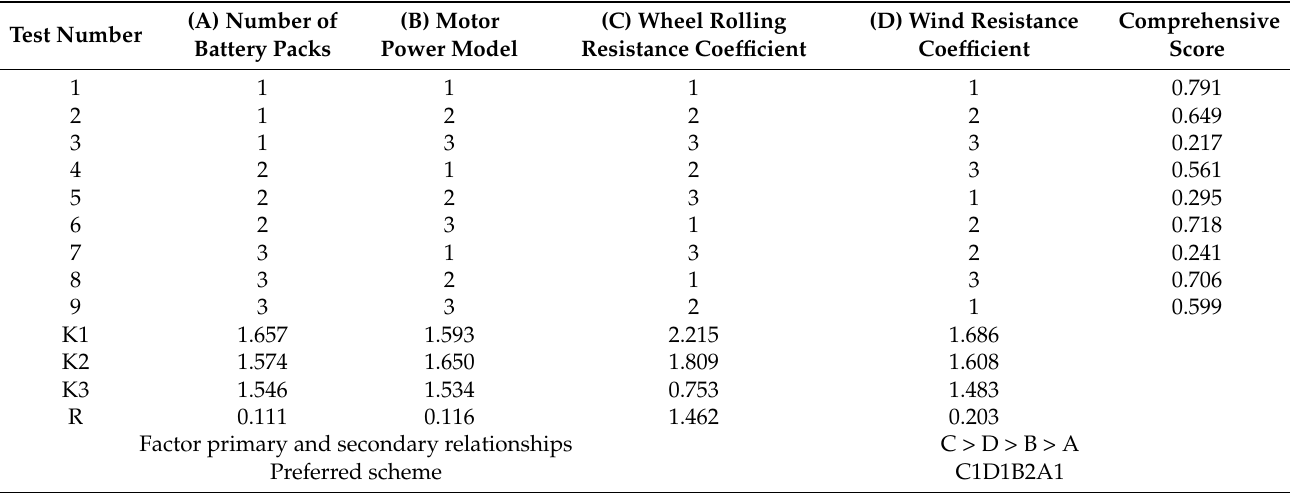
Table 14. Analysis table of experimental